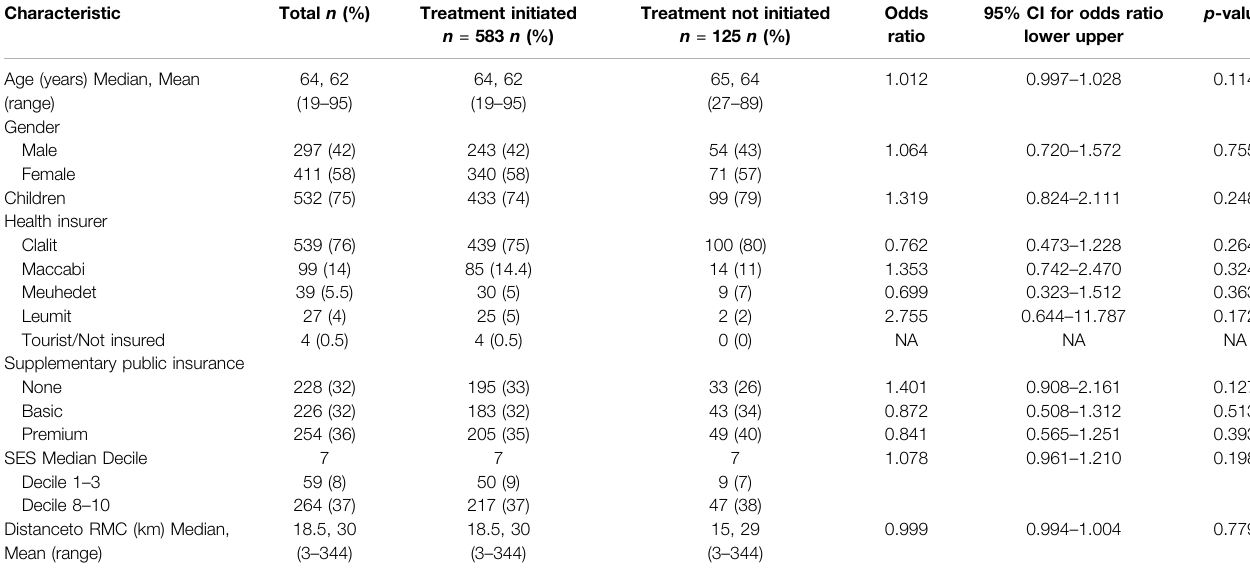
SES, Socioeconomic status; RMC, Rabin Medical Center; km, kilometers. Gender is for Males compared to Females.